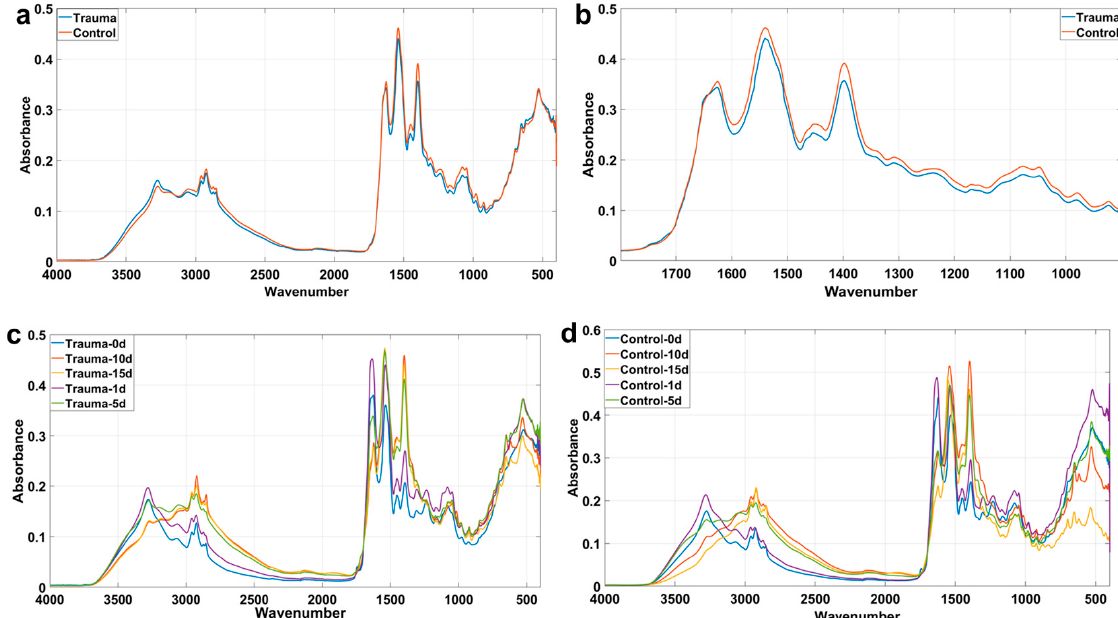
Figure 2. Average spectrogram and peak diagram of biological fingerprint area of trauma group and control group. ( a ) Mean spectrogram of trauma group and control group; ( b ) biometric fingerprint region of the mean spectrogram of the trauma group and the control group; ( c ) mean spectrogram of trauma group at different times; ( d ) mean spectrogram of the control group at different times.